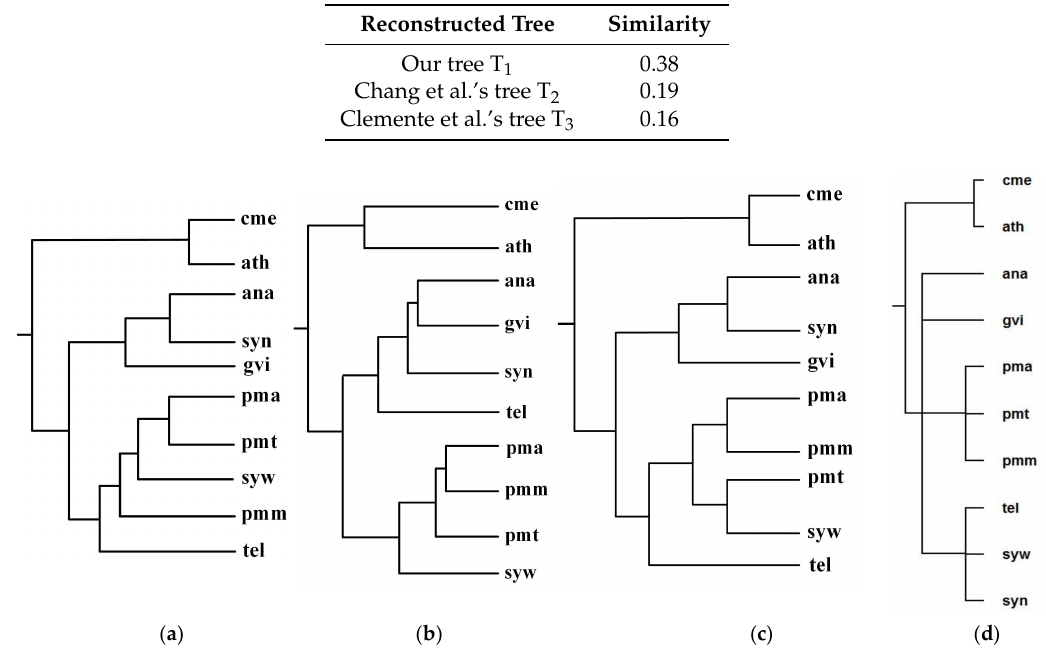
Table 1. Similarity of reconstructed tree to the NCBI taxonomy T for the organisms in Figure 5.